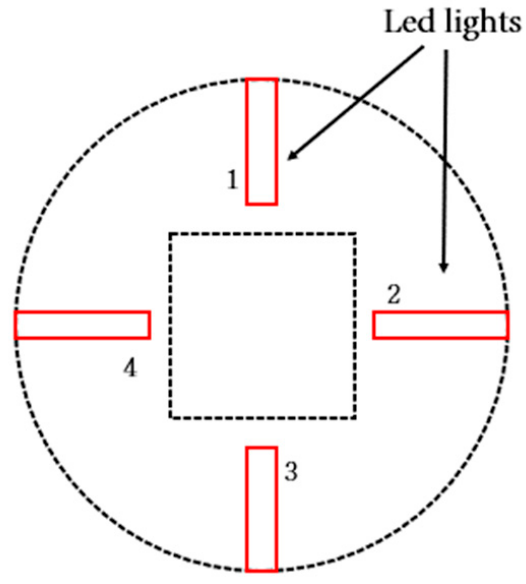
Figure 5. LED lights (top view).